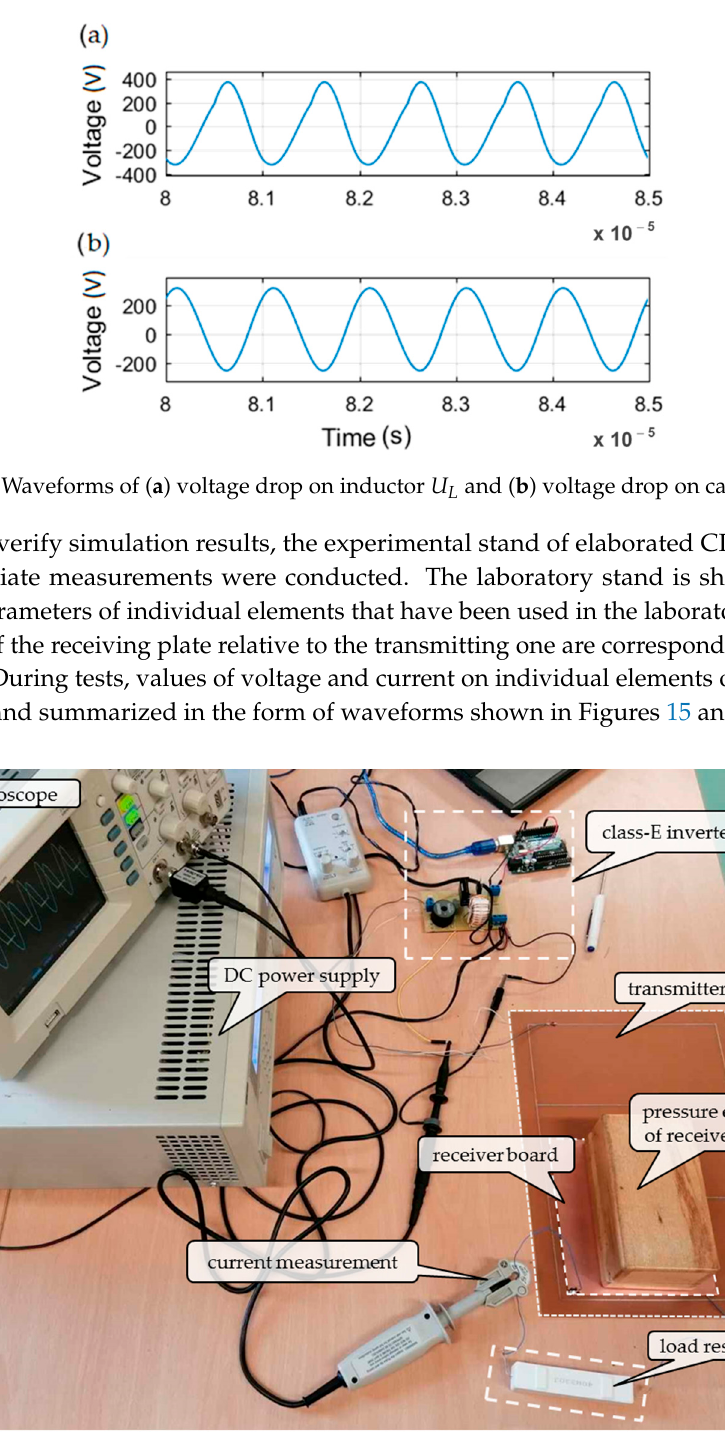
Figure 14. The experimental stand of the elaborated CPT system.